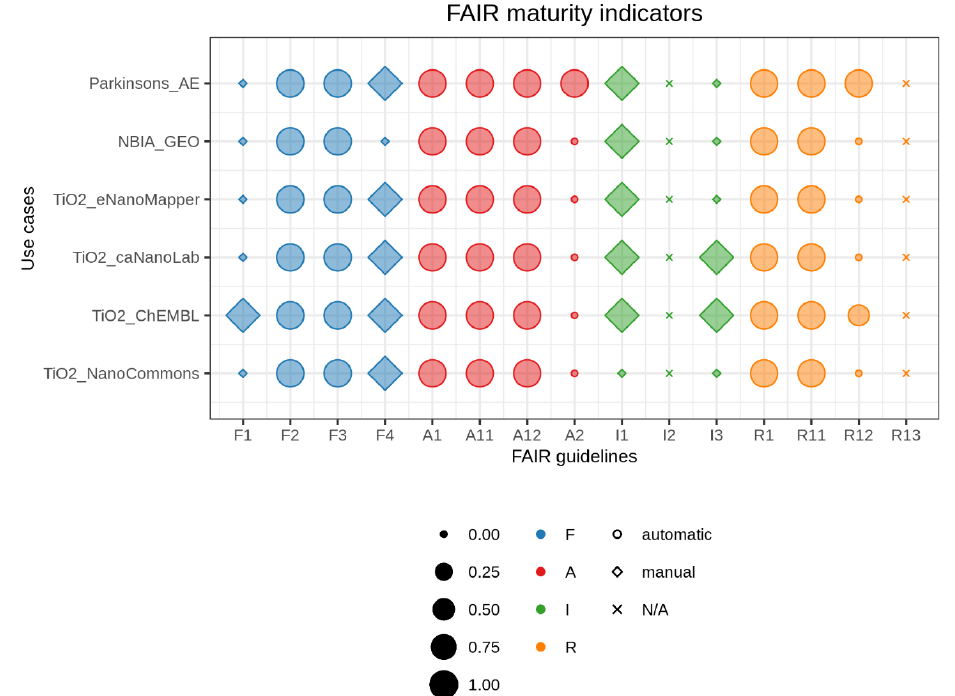
Figure 1. FAIR balloon plot. Comparative summary of FAIR maturity indicators for the six databases evaluated in this work. Size corresponds to the numerical value of mutual indicators, colors represent FAIR categories, and shapes illustrate the way we retrieved information (N / A = not available). The graph can be fully reproduced from our Jupyter Notebook on